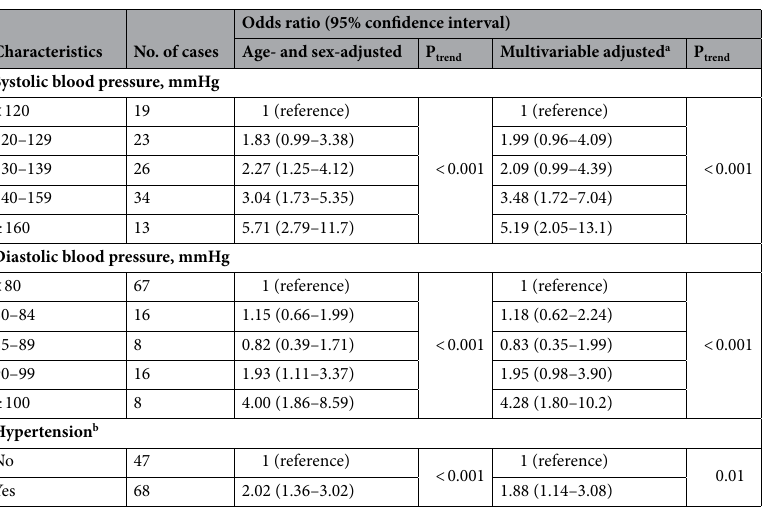
Table 3. Odds ratios of ocular hypertension according to systolic and diastolic blood pressures and hypertensive status. LDL, low-density lipoprotein. a Adjusted for age, sex, smoking status, alcohol intake, diabetes, body mass index, LDL-C level, and central corneal thickness. For systolic blood pressure and diastolic blood pressure, we have additionally adjusted for use of any antihypertensive medication. b Hypertension was defined as use of any antihypertensive medication, systolic blood pressure ≥ 140 mmHg, and/or diastolic blood pressure ≥ 90